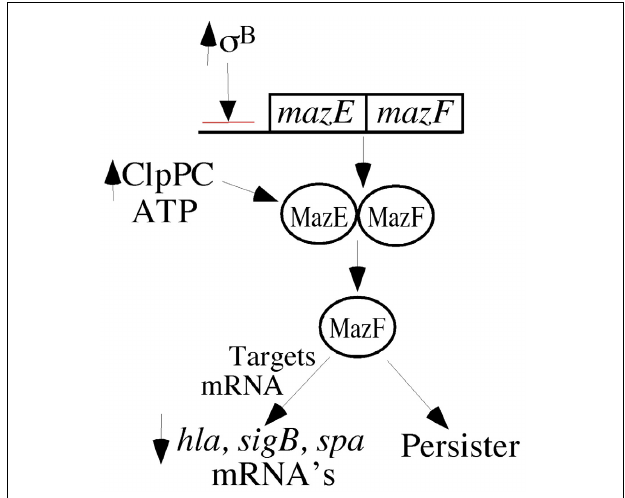
FIGURE 2 | MazEF are transcripbed as a pair of proteins, and their transcription is negatively regulated by SigmaB. MazE is an anti-toxin protein that binds to MazF, thereby preventing its activity. MazF has RNase activity, which targets selected mRNAs in S. aureus . The ATP-dependent protease pair, ClpPC, digests the MazE antitoxin, thereby releasing MazF. Increased MazF has been associated with